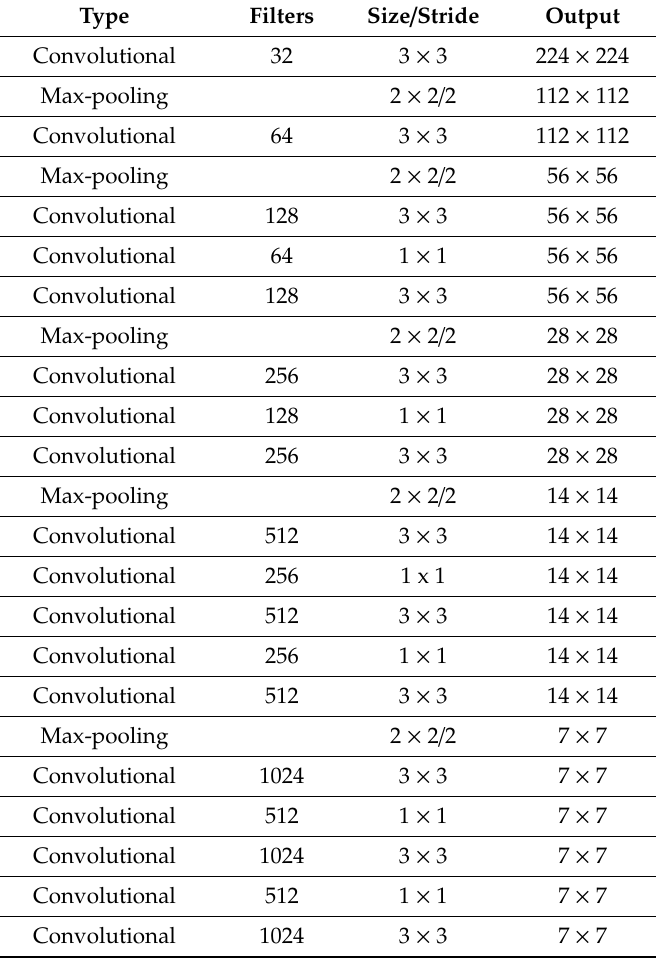
Table 2. Configuration of TSBBR for tiny objects.